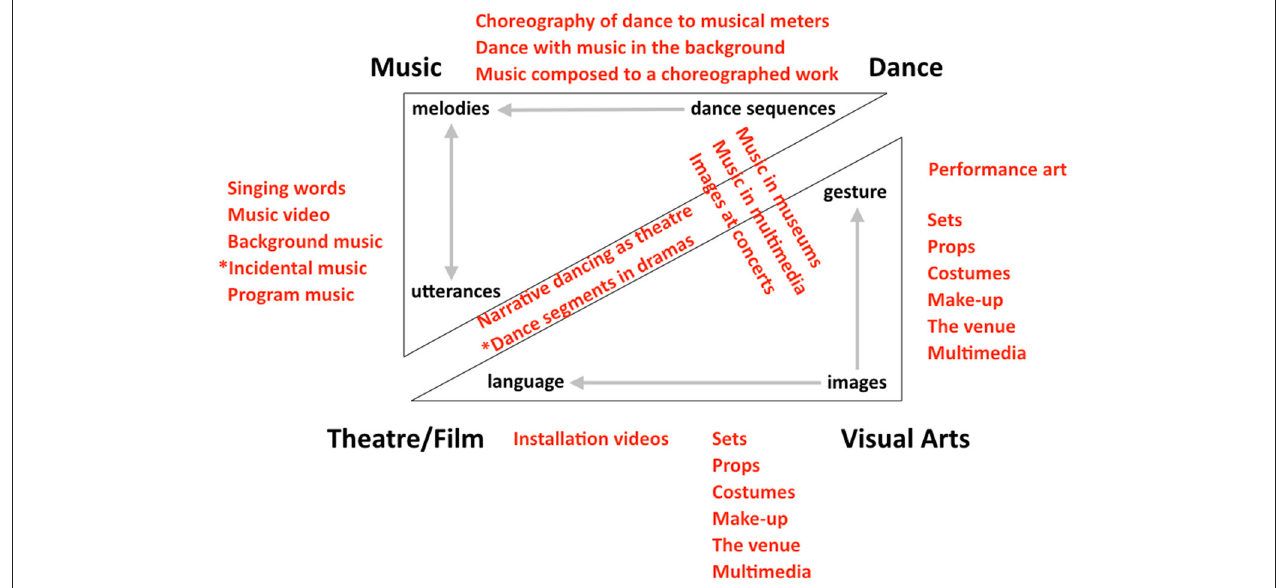
FIGURE 2 | Interactions among the arts. The same double-triangle representation from Figure 1 is shown here. In red text are the six types of two-way interactions between artforms. The directionality of the gray arrows in the top triangle implies that dance is often (though by no means always) performed to a musical beat, and that songs can be created by either setting pre-existing texts to music or by adding words to a pre-existing melody. The directionality of the gray arrows in the bottom triangle implies that visual forms—such as sets, props, costumes, and make-up—are generally created in the service of performance forms, such as theater and dance. Whereas most interactions involve simultaneous combinations of artforms, the interactions marked with asterisks (i.e., incidental music, and dance in verbal dramas) are those that tend to occur in alternation with one